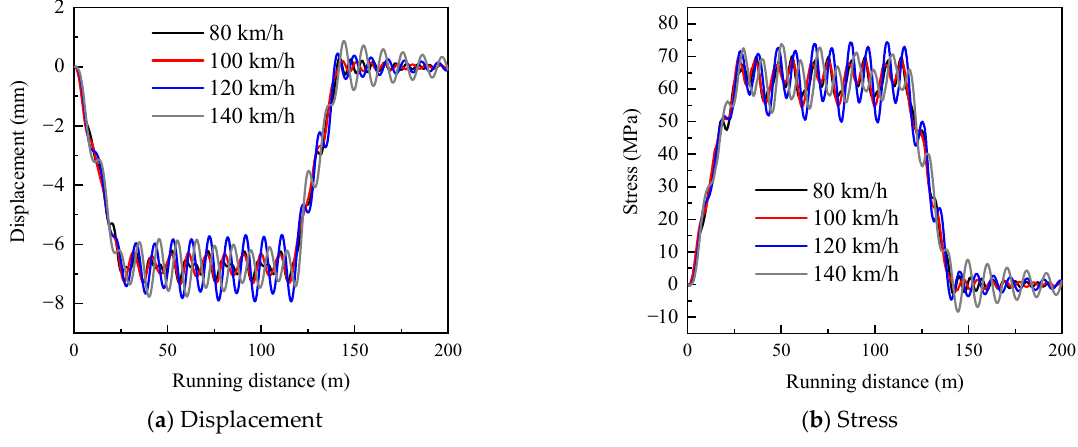
Figure 5. Time–history response curves of midspan of 30-m bridge. As can be seen from Figure 5a, the ergodic curve trend of bridge displacement response under different vehicle speeds is basically the same. When the vehicle speed is small (below 100 km/h), its dynamic deflection is relatively small, and its dynamic amplitude is small. It can be found from Figure 5b that as the vehicle enters the bridge, the stress of the tensile reinforcement at the bottom of the girder gradually increases, peaking at around 70 MPa, and then presents vibrations of varying amplitudes as the vehicle continues to move forward (the amplitude is about 13 MPa below 100 km/h and about 20 MPa above 100 km/h), with multiple peaks and troughs. After the vehicle leaves the bridge, the tensile stress decreases gradually, and finally oscillates near 0 MPa and disappears